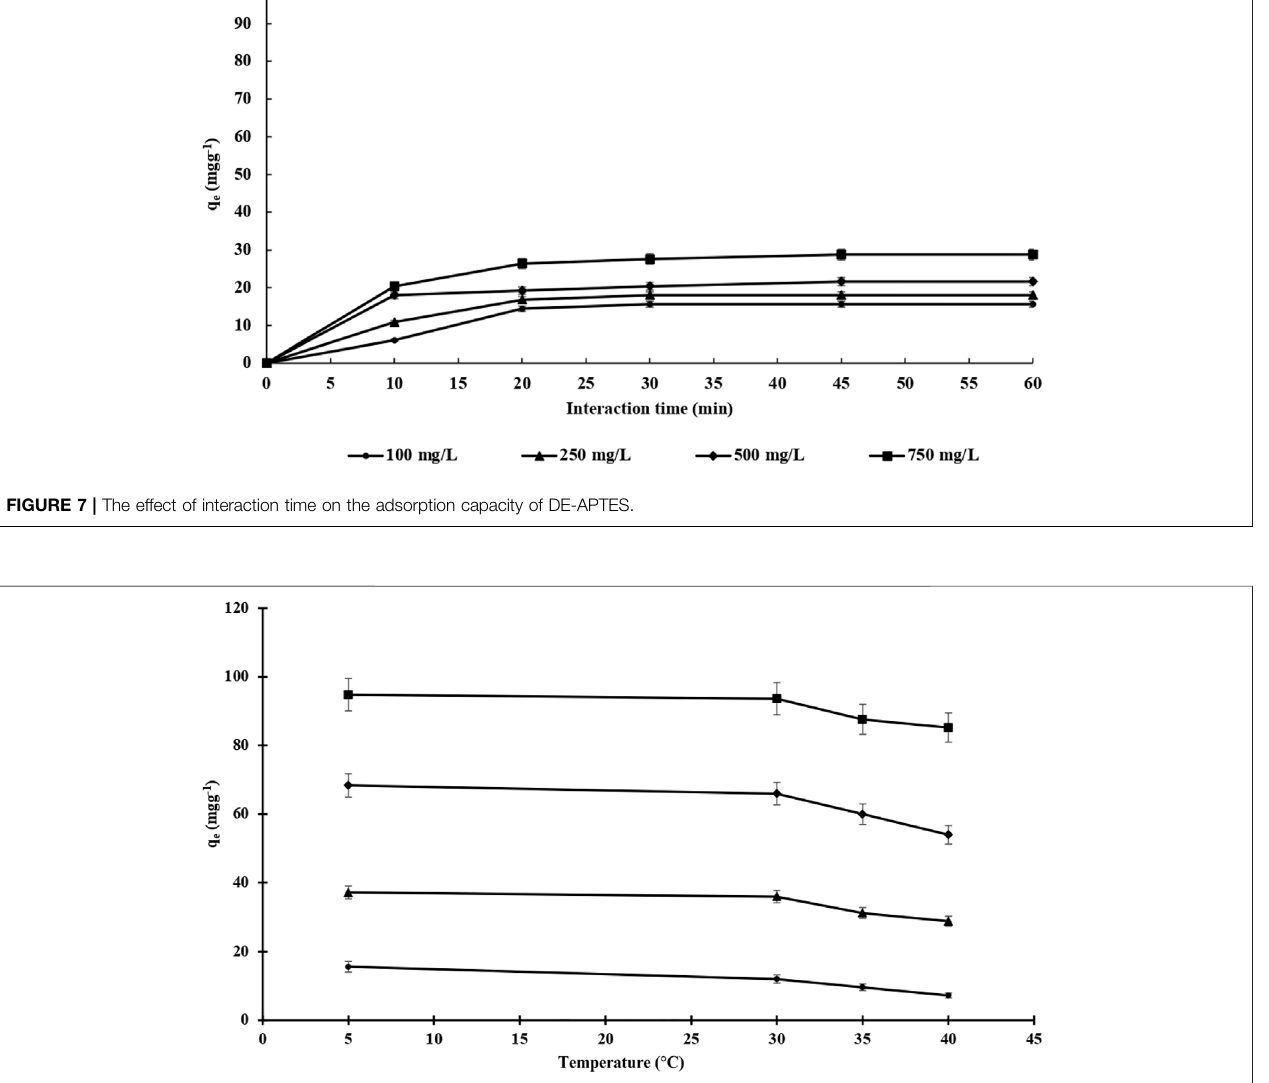
Frontiers in Chemistry |